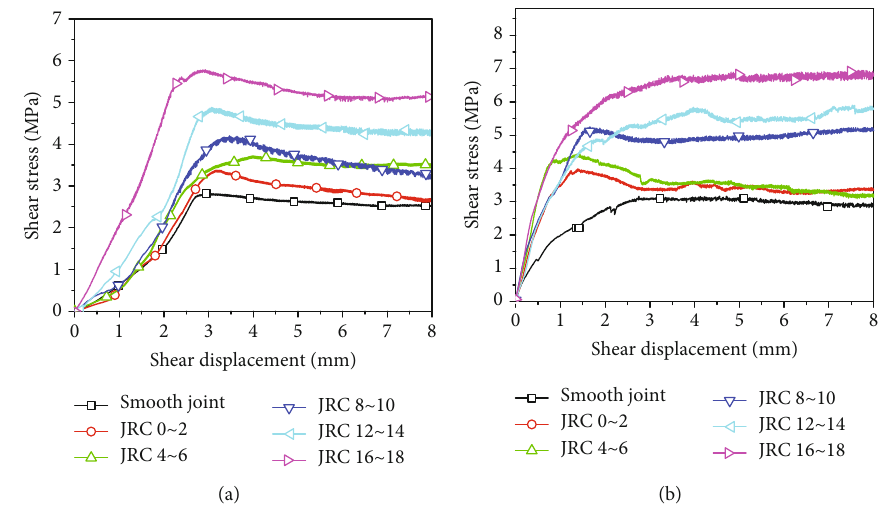
Figure 2: Curves of shear stress vs. displacement of low-strength and high-strength rock joints: (a) low-strength rock joints; (b) high- strength rock joints. Table 1: Shear strength of joint with di ff erent lithologies. Low-strength rock mass High-strength rock mass Joint surface type